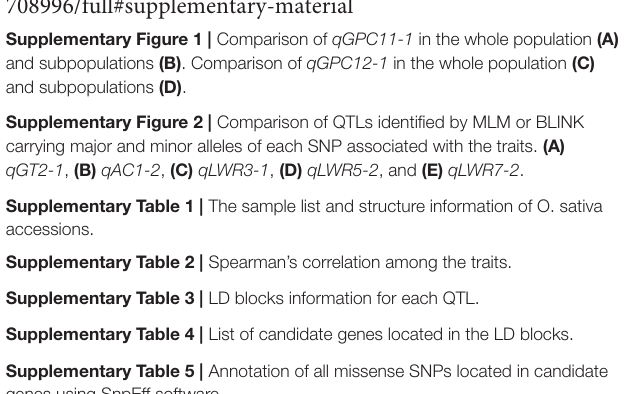
Supplementary Table 1 | The sample list and structure information of O. sativa accessions. Supplementary Table 2 | Spearman’s correlation among the traits. Supplementary Table 3 | LD blocks information for each QTL. Supplementary Table 4 | List of candidate genes located in the LD